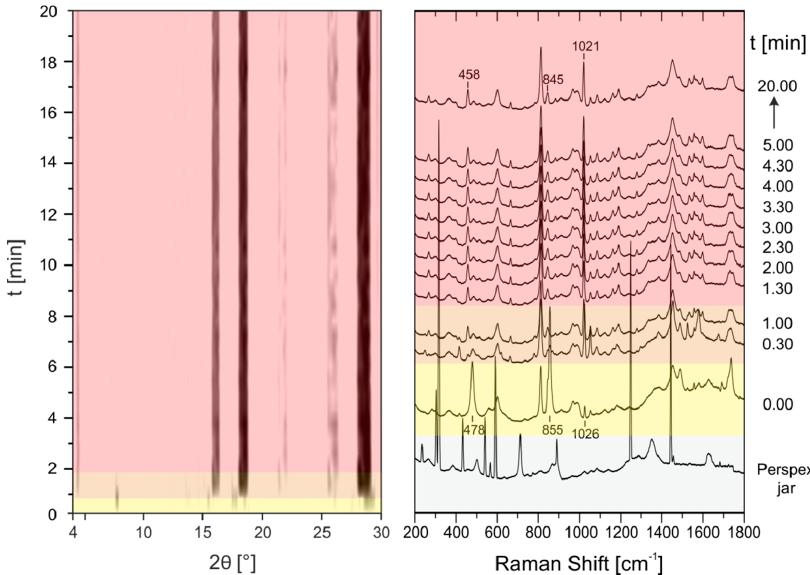
Figure 4. Time resolved investigation of the synthesis process of the PZA:OA (1:1) cocrystal obtained by neat grinding of PZA with oxalic acid dihydrate followed in situ by synchrotron XRD ( left ) and Raman spectroscopy ( right ). The Raman spectrum of the empty Perspex jar (gray) indicates which modes of the following synthesis process arise from the sample holder and which from the reaction mixture. Yellow: reactants; orange: reactants and product; red: product.